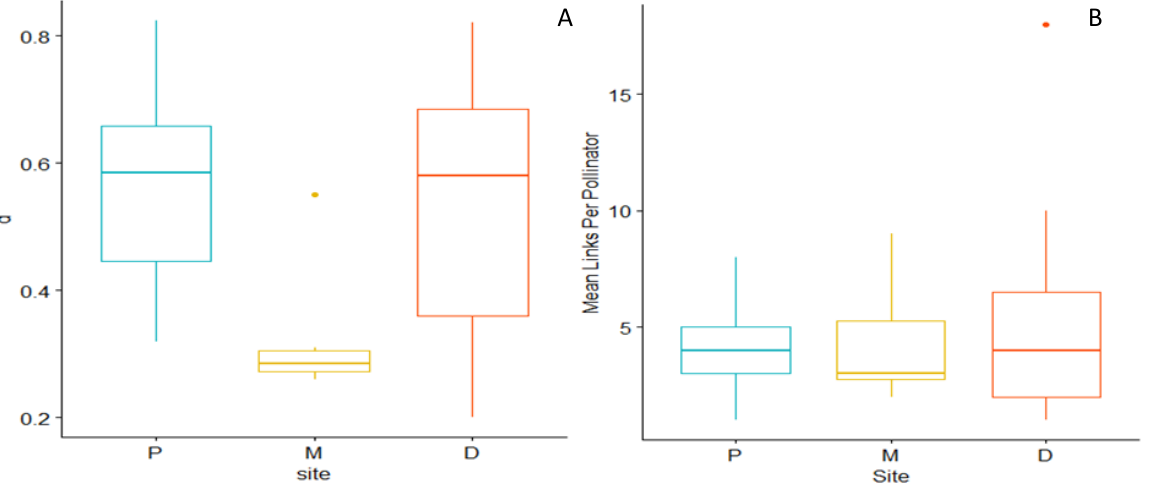
F IGURE 5: Box plots for (A) species-level specialization values (d’), and ( B) mean links per pollinator for the 16 pollinator species found in all three sites. P=Pristine; M=Late Successional; D=Early Successional. No significant differences were